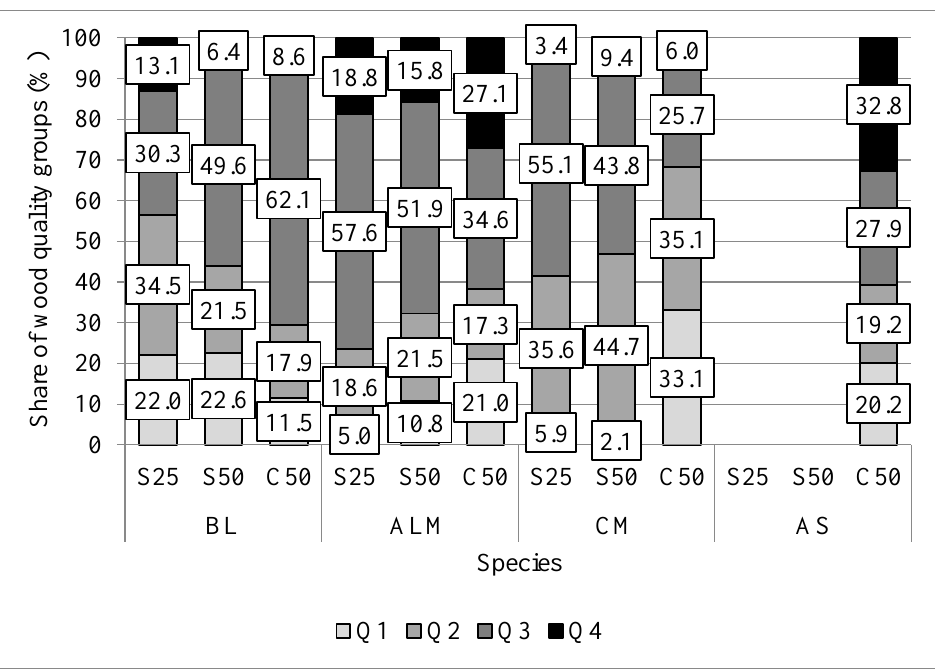
Figure 6. Share of wood quality groups of the studied tree species in individual groups of research plots. Notes: BL — black locust; ALM — ash-leaf maple; CM — common maple; AS — American ash; S25 — combustion waste covered with sewage sludge, 25 cm thick; S50 — combustion waste covered with sewage sludge, 50 cm thick; C50 — clay-covered combustion waste; Q1, Q2, Q3, Q4 — wood quality groups.